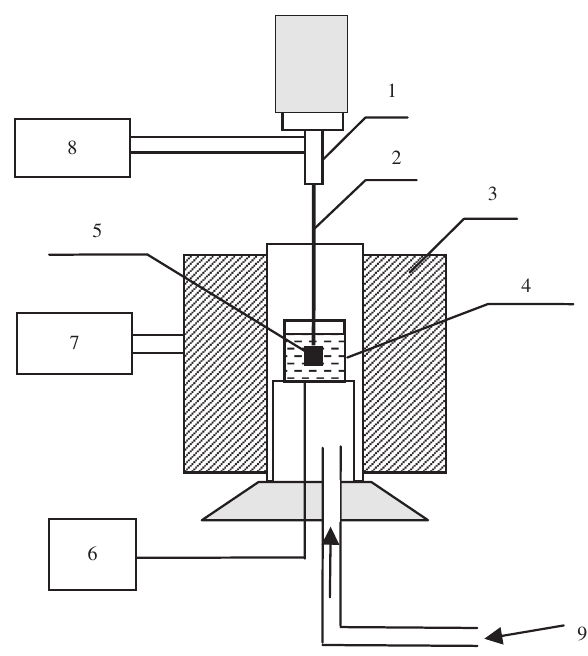
Figure 1: Schematic diagram of experimental apparatus: 1, torque sensor; 2, rotating rods; 3, high temperature furnace; 4, graphite crucible; 5, probe; 6, thermocouple; 7, control cabinet; 8, computer system; 9, N 2